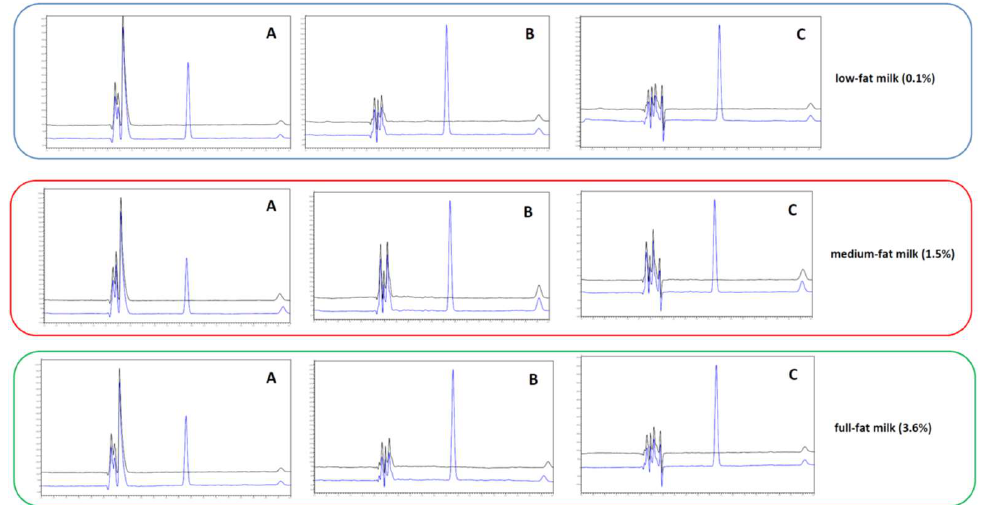
Figure 1. Representative overlaid chromatograms of blank FaSSGF:milk, 4:1, at different milk fat content levels (0.1, 1.5 and 3.6%) extracted with ( A ) 10% v/v aq. solution of TFA, ( B ) MeOH and ( C ) ACN. The chromatographic conditions are described in Section 2.2.